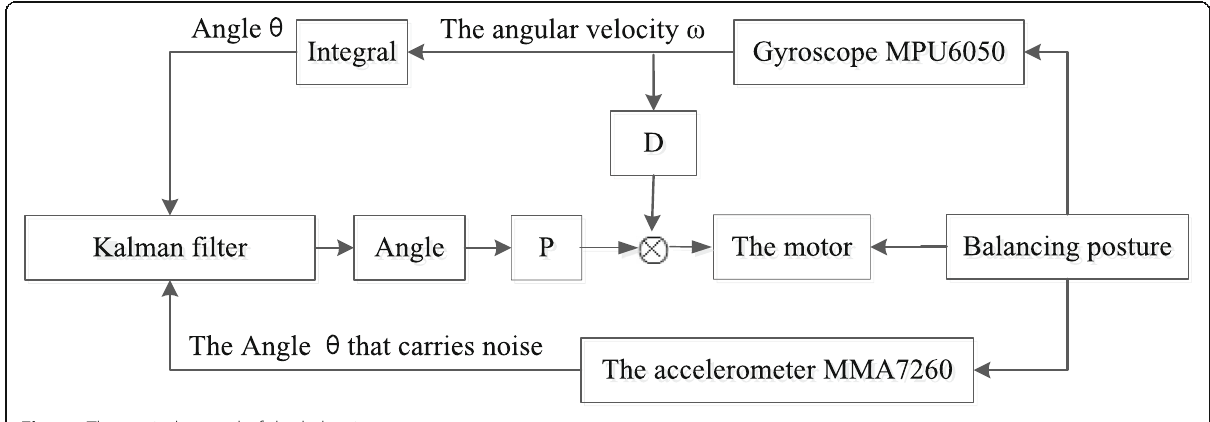
Fig. 15 The vertical control of the